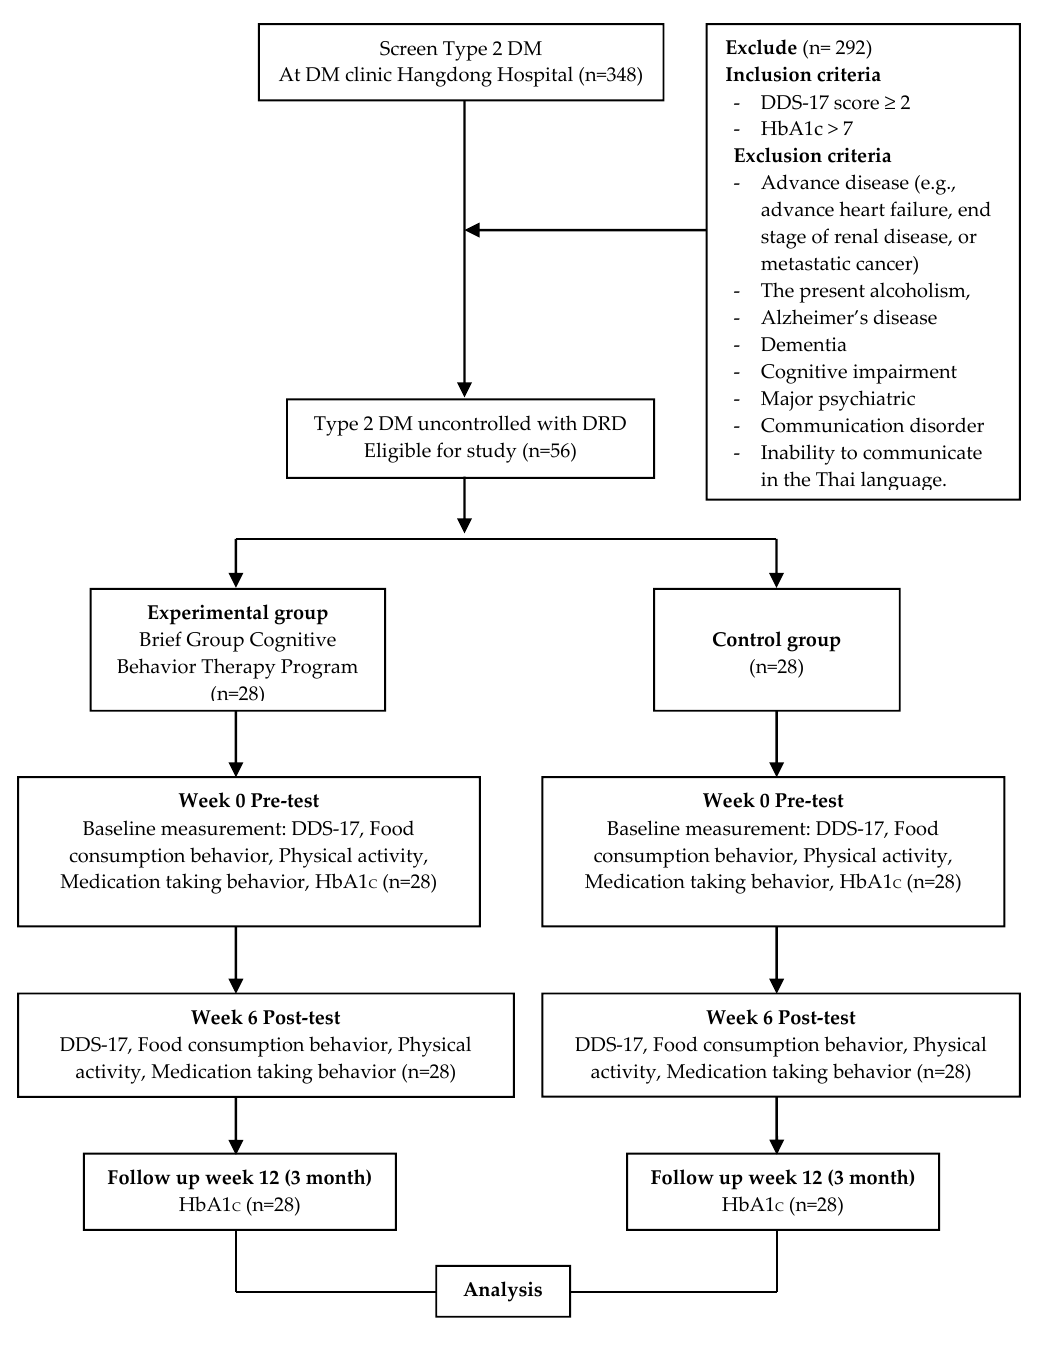
Figure 1. Flow chart of study procedure.